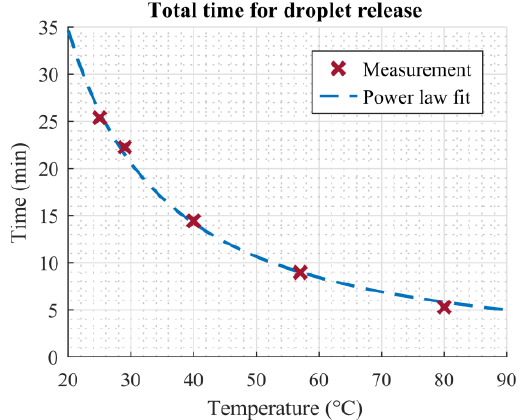
Figure 9. Time required until the last droplet is released vs. temperature. Red crosses show measured data, the dashed blue line shows a power law fit ( t = aT b , r 2 = 0.9954).